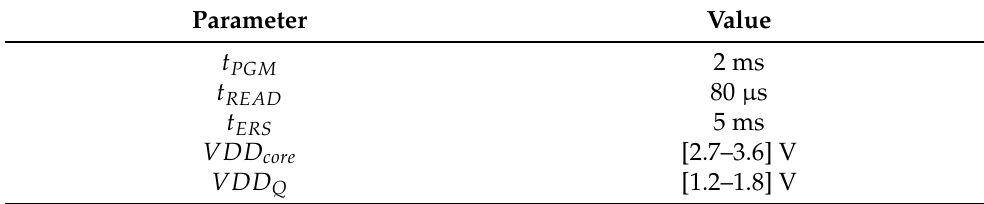
Table 2. The 3D NAND Flash operation timings and voltage intervals considered in the